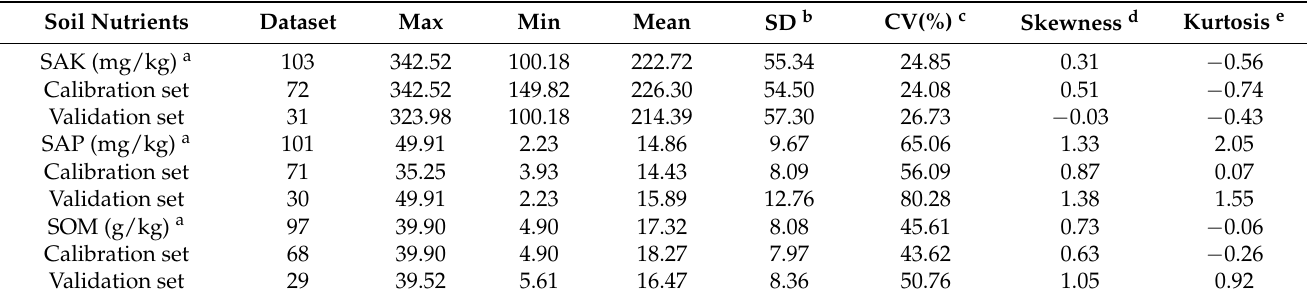
Table 1. Descriptive statistics of soil nutrients in the study